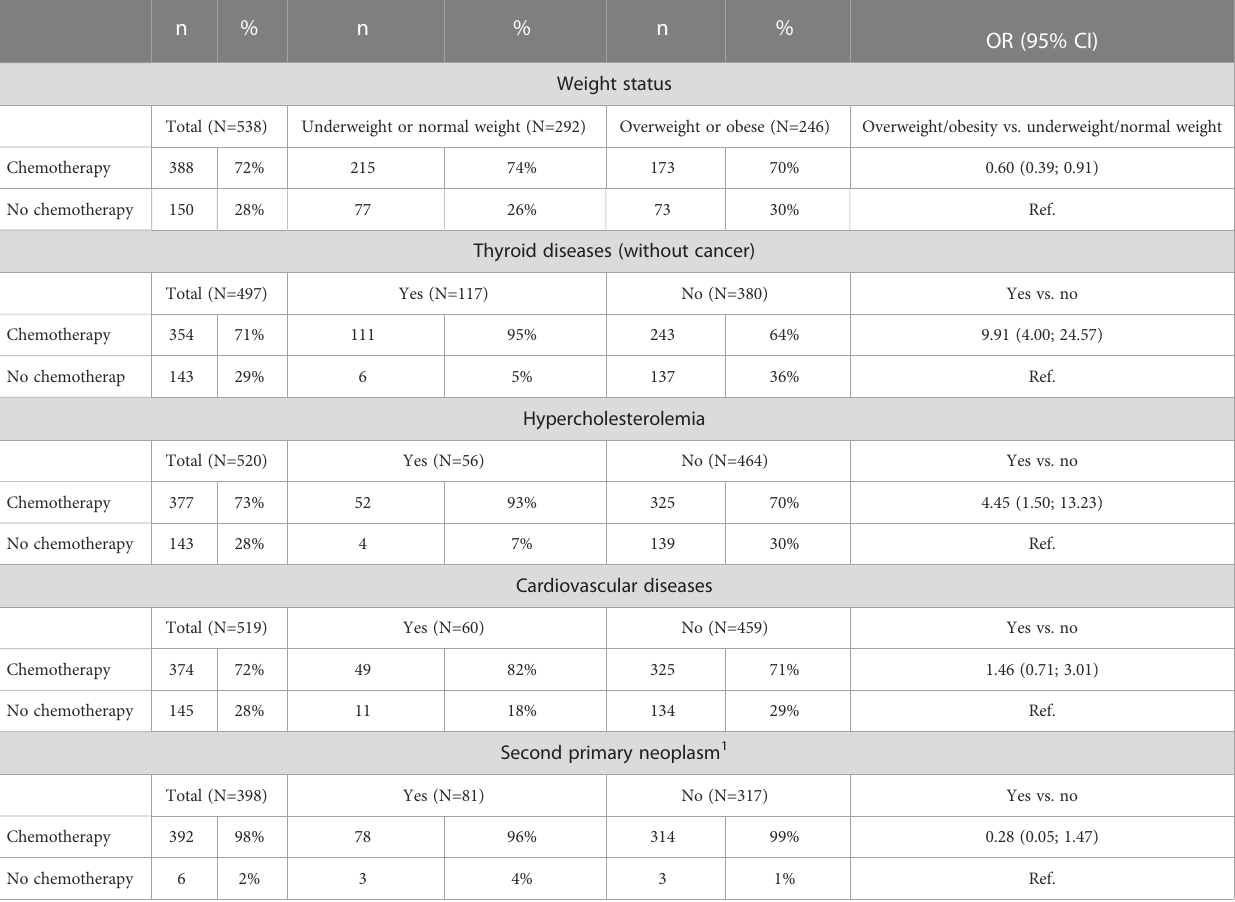
TABLE 5 Self-reported exposure to chemotherapy and risk of later adverse health effects in participants of the KiKme case-control